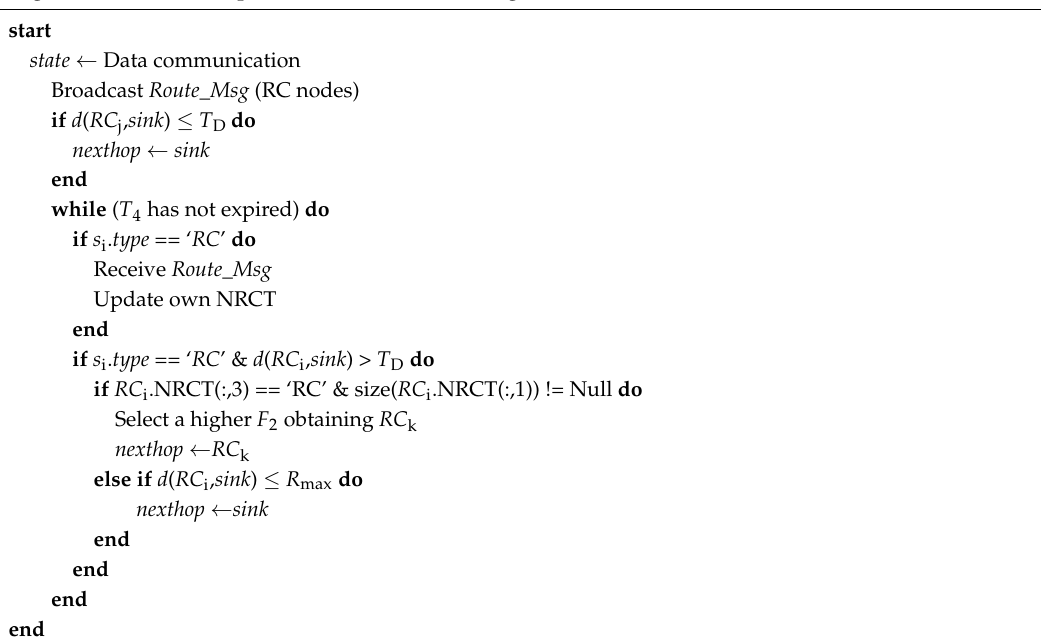
Algorithm 3: Inter-subspace data communication